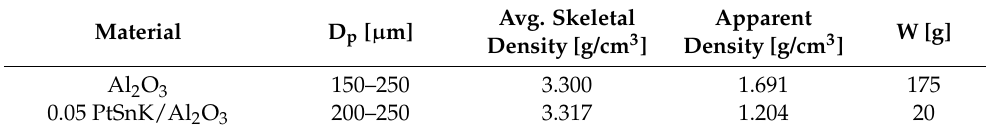
Table 2. Catalyst and filler particles physical